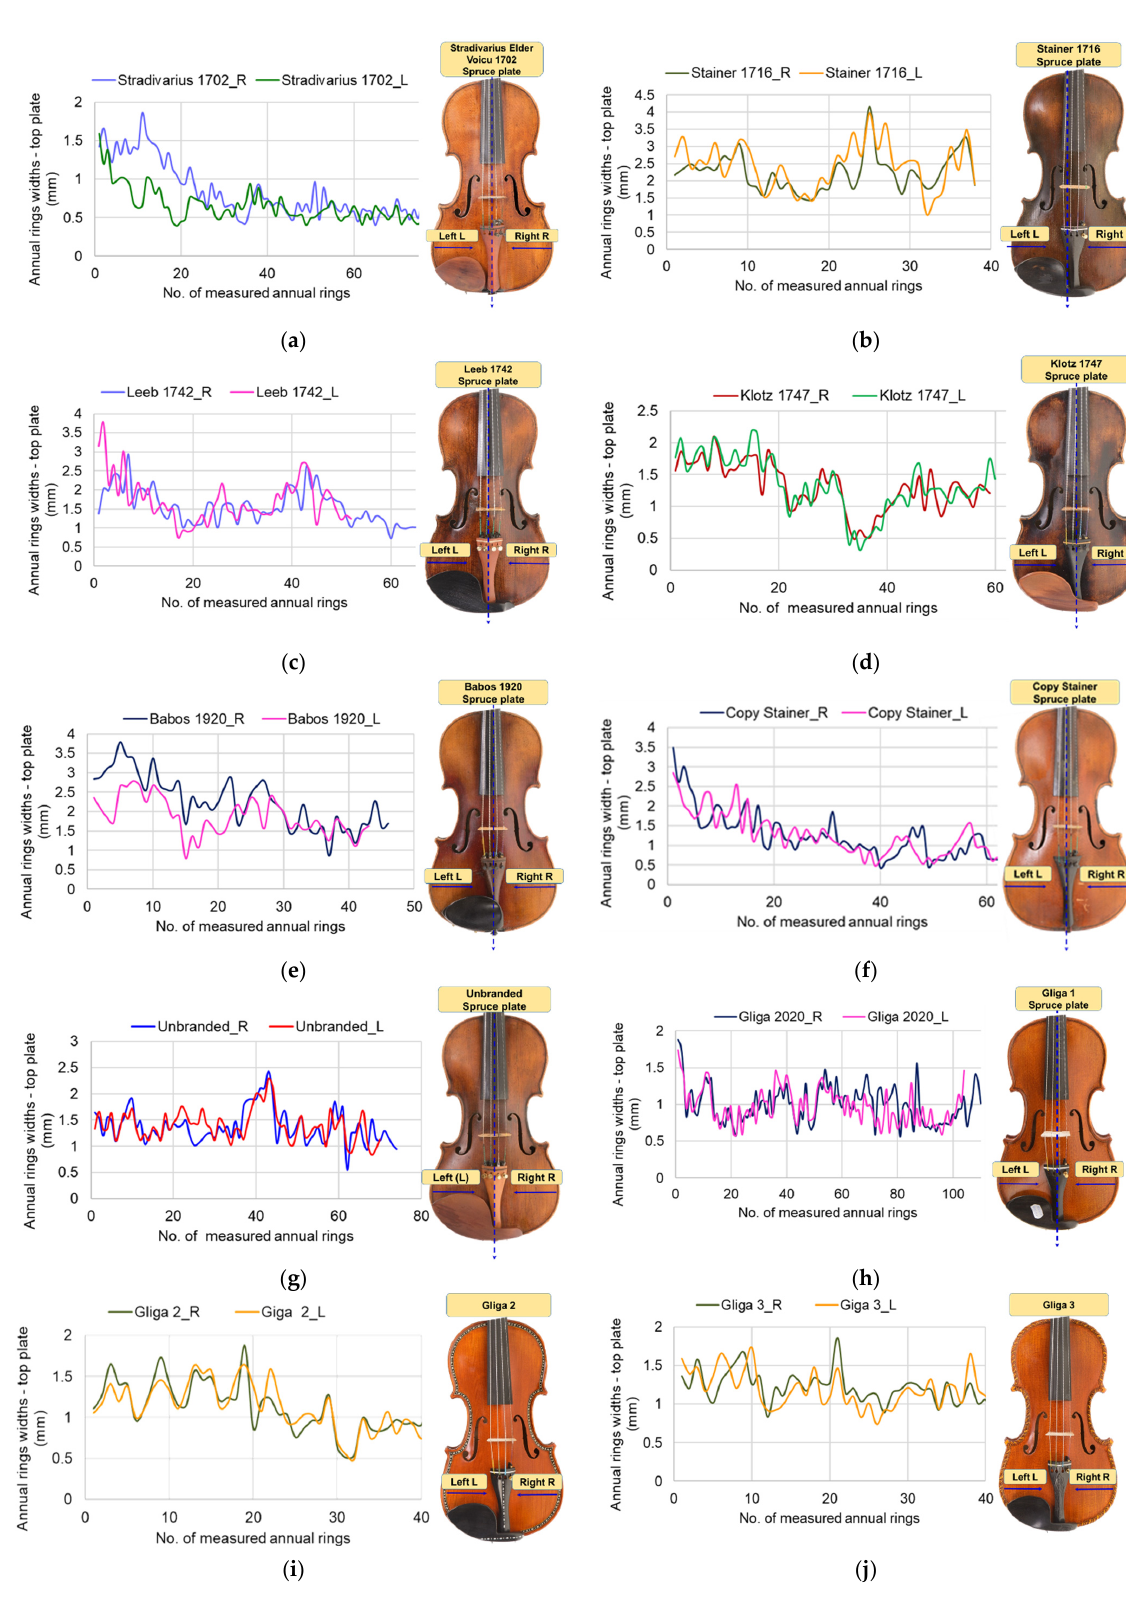
Figure 6. Analysis of the symmetry of the anatomical structure of spruce wood in the construction of violin top plate made from resonant spruce: ( a ) Stradivarius Elder Voicu 1702 violin; ( b ) Stainer 1716 violin; ( c ) Leeb 1742 violin; ( d ) Klotz 1747 violin; ( e ) Babos 1920 violin; ( f ) Copy Stainer violin; ( g ) Unbranded violin; ( h ) Gliga 1, 2020 violin; ( i ) Gliga 2 violin; ( j ) Gliga 3